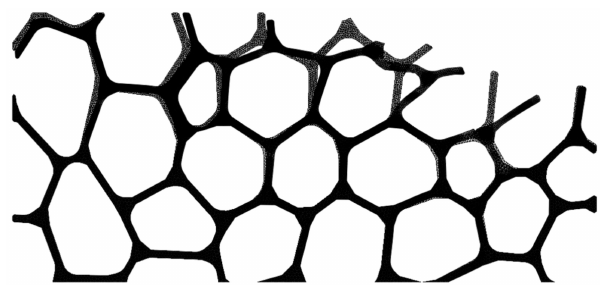
Figure 10. Mesostructure before (grey) and after the second sweep (black) for down milling (Model A, v c = 100 m / min, f z = 0.30 mm). Cell distortion is limited to cells in the upper section.